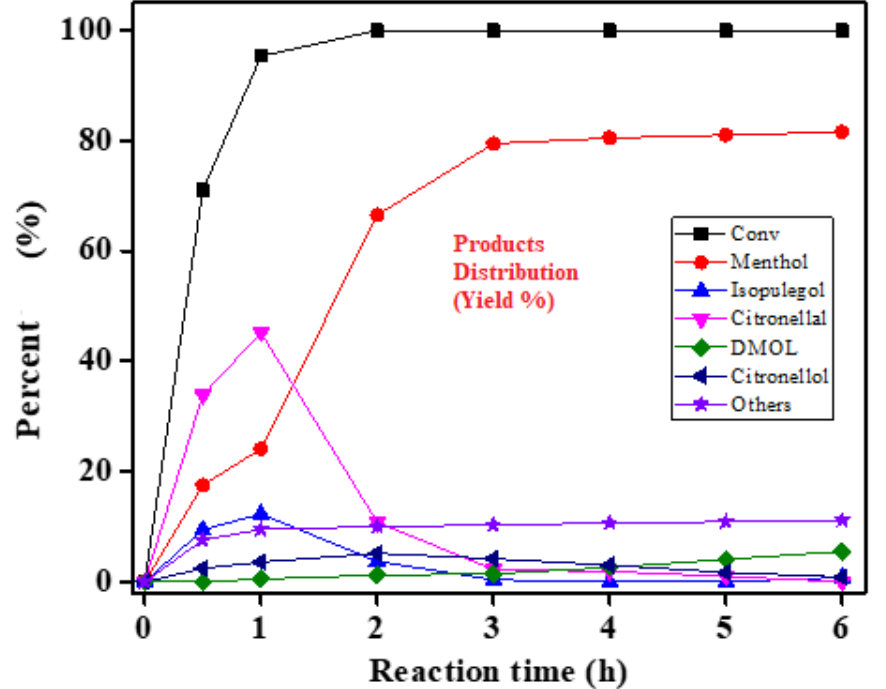
Figure 11. The conversion and product distribution of citral hydrogenation given by nickel-supported hierarchical zeolite catalyst (Ni/HZ-0.5 M).